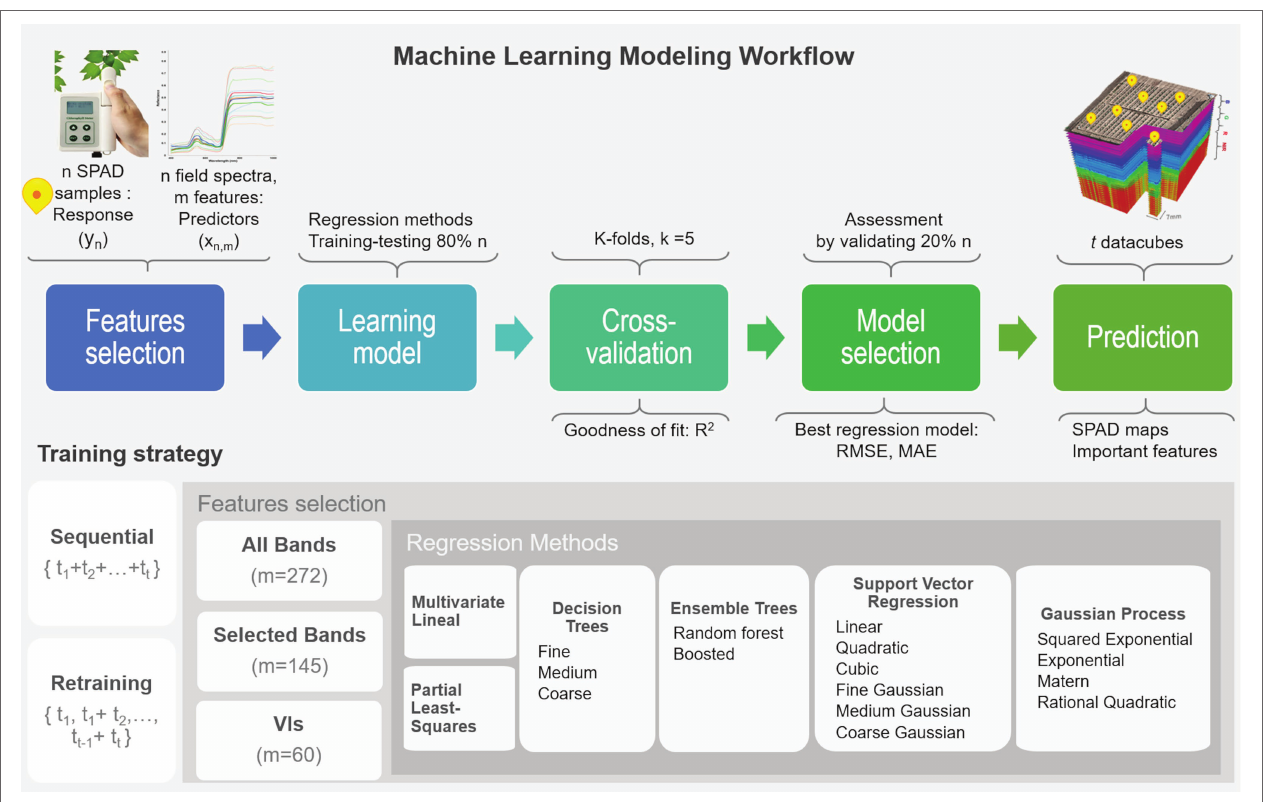
FIGURE 3 | Machine learning workflow for the retrieval of multi-temporal leaf chlorophyll dynamics using ultra-high-resolution UAV-hyperspectral imagery. The retraining loop should operate using the selected algorithms by starting from the first dataset (i.e., t = 1), then re-running the fitting process on the next training datasets, but using the previously fitted predictor variables and hyper-parameters (i.e., t 1 + t 2 , t 2 + t 3 ). In this way, the model is updated as new training data is used in the learning process, and predictions are estimated